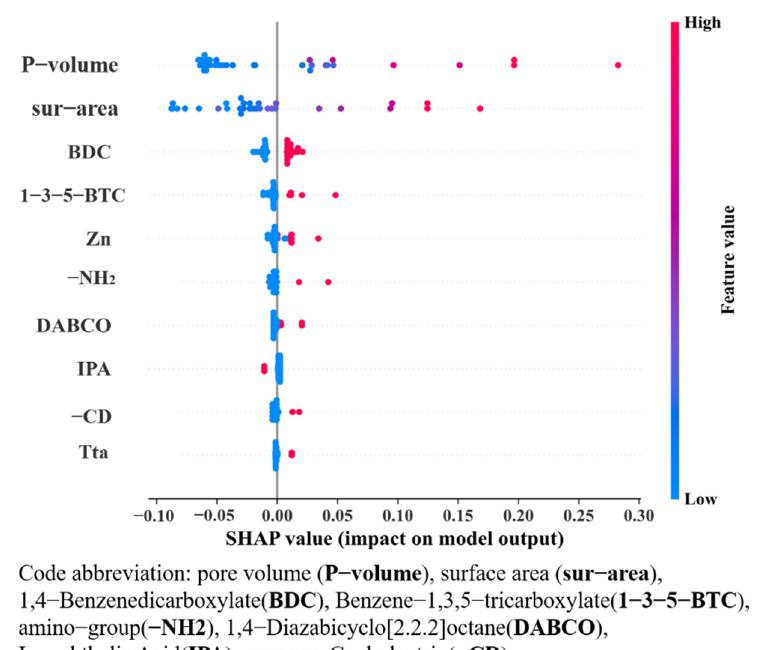
Figure 8. The SHAP plot for the visualization of the main effects of the features.